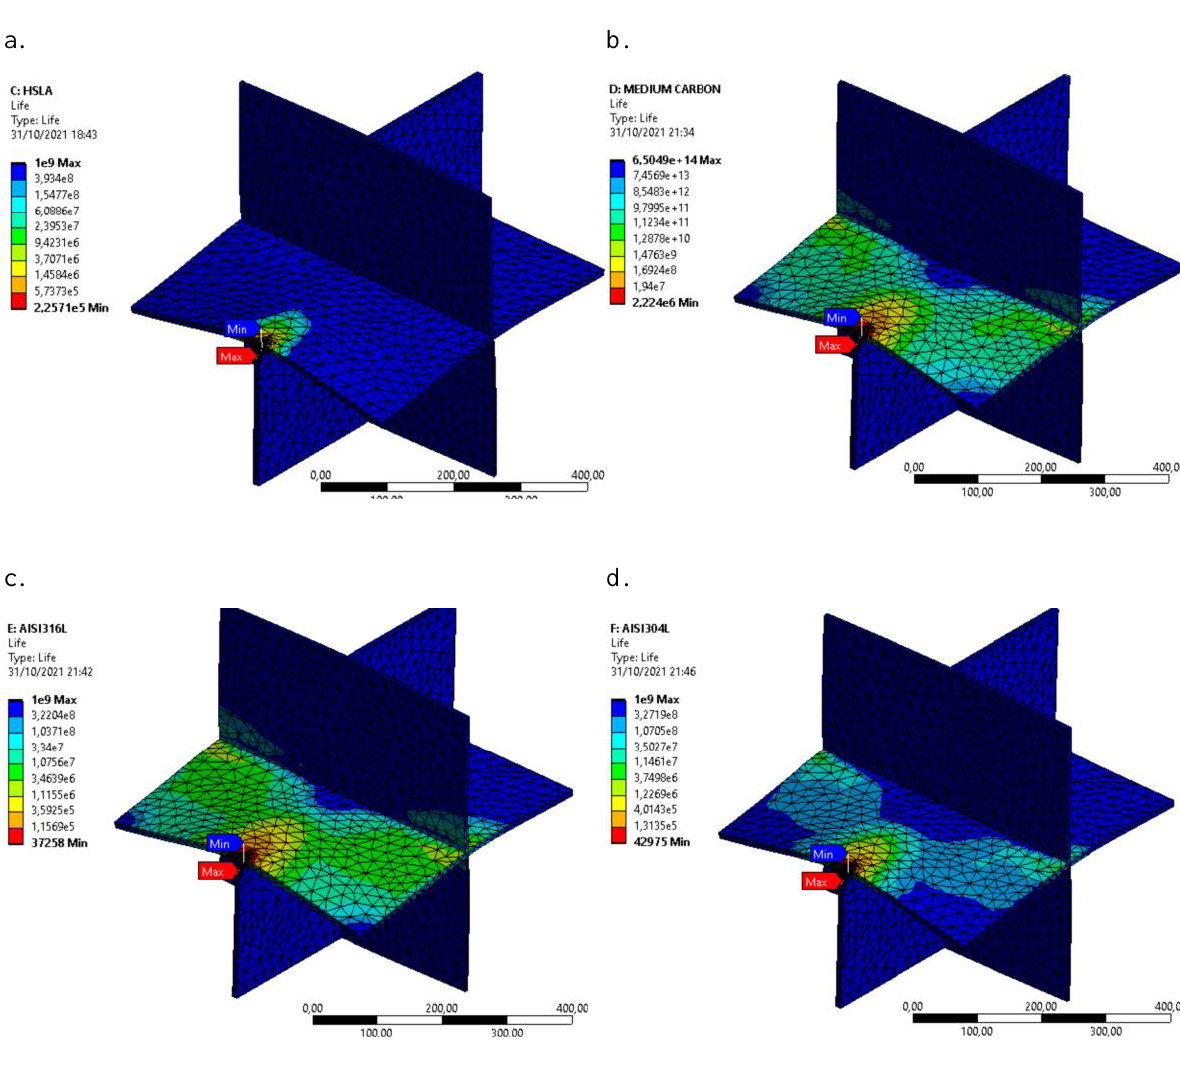
Figure 18. Fatigue Life: a. HSLA 950X; b. Medium-Carbon; c. SAE 316L; d. SAE 304L Figure 18: Fatigue life: a. HSLA 950X; b. Medium-carbon; c. SAE 316L; d. SAE